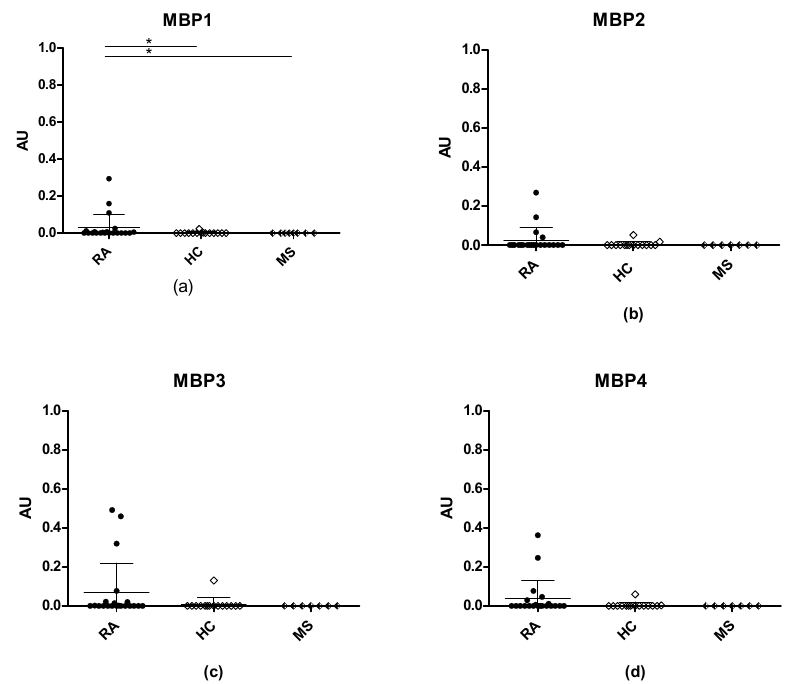
Figure 5. Reactivity of sera from rheumatoid arthritis (RA), multiple sclerosis (MS), and healthy controls (HC) to citrullinated MBP peptides analyzed by enzyme-linked immunosorbent assay: ( a ) reactivity of RA, MS and HC sera to MBP1; ( b ) reactivity of RA, MS and HC sera to MBP2; ( c ) reactivity of RA, MS and HC sera to MBP3; ( d ) reactivity of RA, MS and HC sera to MBP4. * p < 0.05.